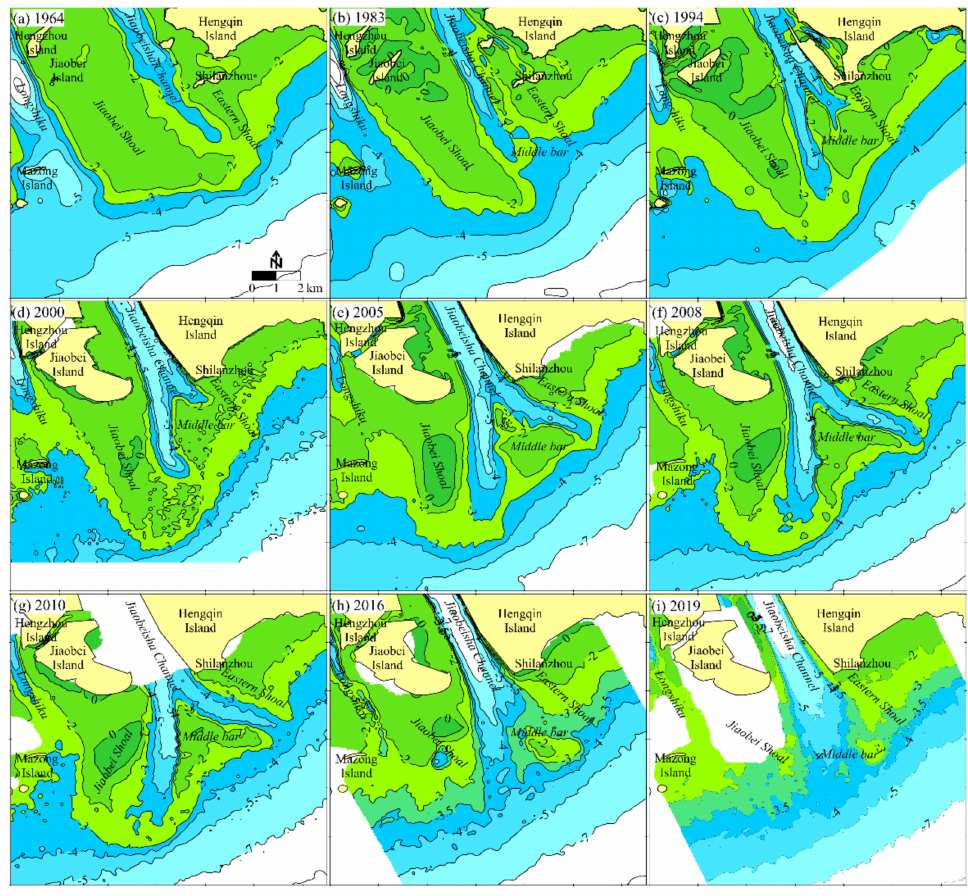
Figure 2. Underwater topography of the mouth bar from 1964 to 2019. ( a – i ) are the topography measured in 1964, 1983, 1994, 2000, 2005, 2008, 2010, 2016, and 2019,